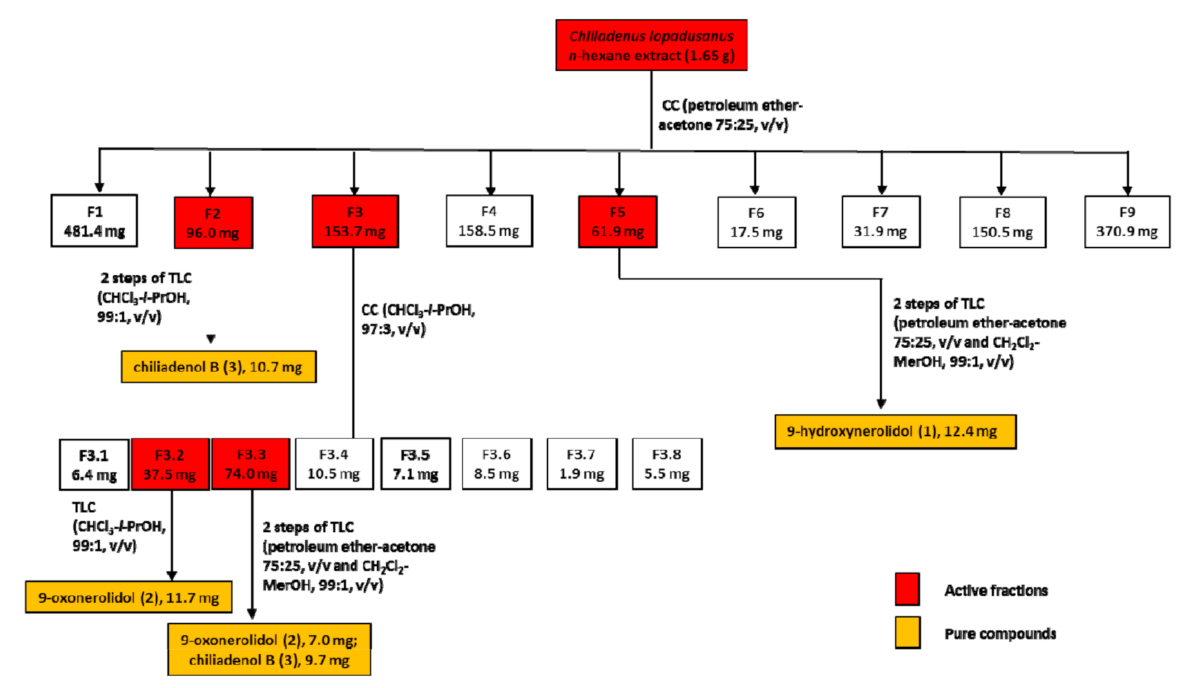
Figure 6. Chromatographic purification diagram of the metabolites extracted from C. lopadusanus